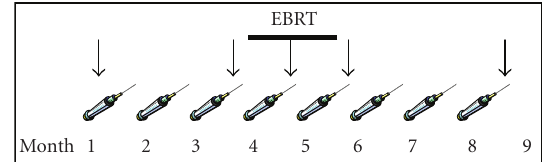
Figure 2: Three monthly vaccines were given before external beam radiation therapy (EBRT, thick line). The initial vaccine was given with an admixture of rV-PSA and rV-B7.1 with follow-up monthly boosts given with recombinant fowlpox PSA. Immunologic studies were performed prevaccination, post-3, post-4, post-5, and post-8 cycles of vaccine (designated by the